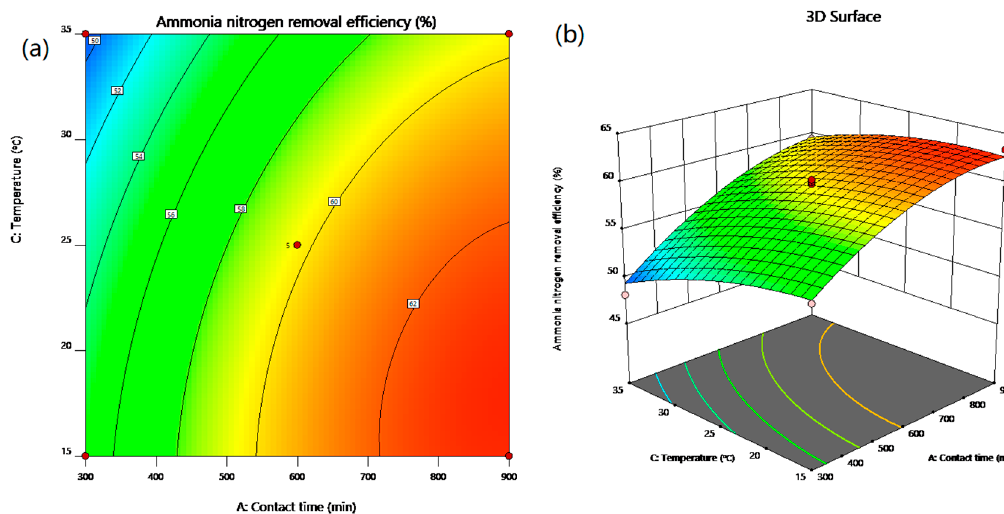
Figure 7. 2D contour plot ( a ) and 3D response surface plot ( b ) showing the effect of contact time and pH on the removal rate of NH 4+ .